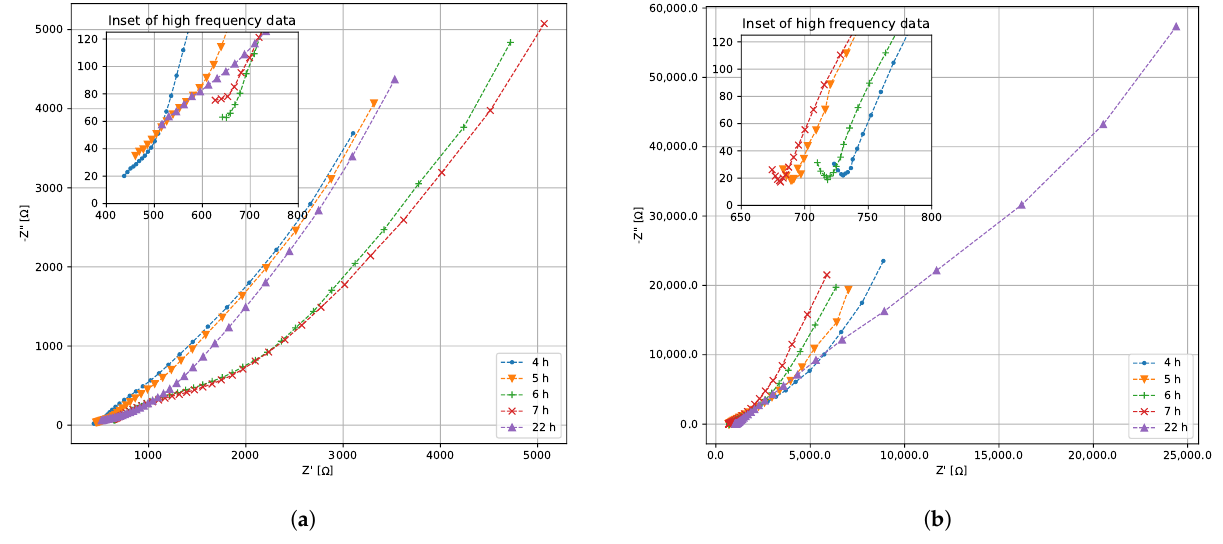
Figure 5. Nyquist plots of the EIS data for K. pneumoniae ( a ) without and ( b ) with Pb(II). The hourly EIS data for the exponential growth phase demonstrate what appears to be a semicircle emerging at higher frequency, specifically in the hour 6 and 7 measurements for Figure 5a, and hours 4–7 in Figure 5b. This is characteristic of a resistor in series with a capacitor [24]. Using this insight, it is assumed that a 0 in Equation (4) is a constant reactive quantity corresponding to this impedance in Ω and the exponent p 1 < 0. The fact that the semicircle is ill-defined indicates that the exponent p 1 is likely not an integer, which suggests an element that acts similarly to a capacitor with b 0 its magnitude in Farad. There is a marked downward curve at the extreme high frequencies counteracting the RC response, especially at hour 22 in Figure 5a. This suggests a positive phase shift at high frequencies, likely attributable to inductance in the wires connecting the measurement setup to the measurement device. From this, p 2 > 0, with c 0 the magnitude of an inductor in